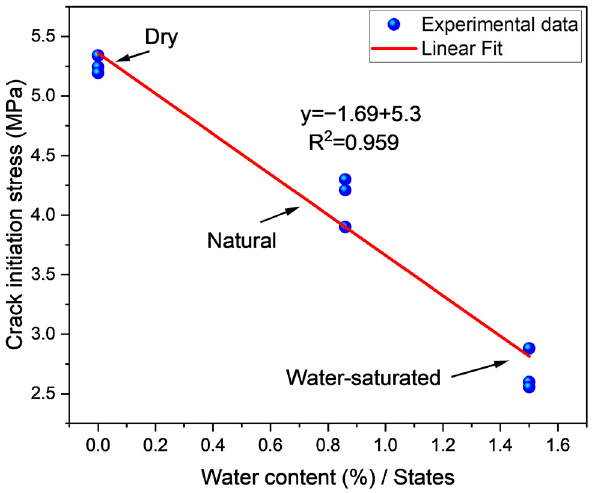
Figure 8. Correlation of different states of coal and peak stress.